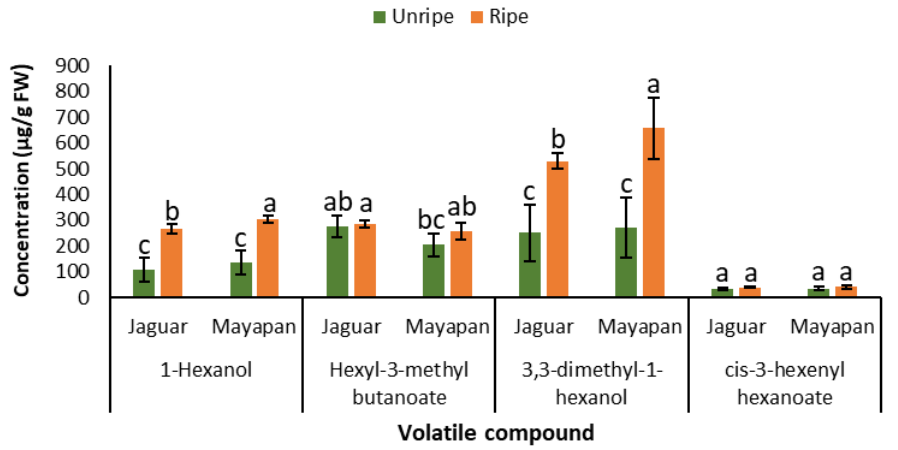
Figure 3. Bar plots of the effect of variety and grade of ripeness on the concentration of: 1-hexanol, hexyl-3-methyl butanoate, 3,3-dimethyl-1-hexanol, and cis-3-hexenyl hexanoate. Error bars represent the standard uncertainty ( p ≤ 0.05). Different letters indicate statistically significant differences using minimum significant differences (MSD) test at p ≤ 0.05 in the same volatile compound. Results presented in the figure are the average of concentrations of the three evaluated soils. The concentration of volatile compounds is expressed on a fresh weight (FW) basis.